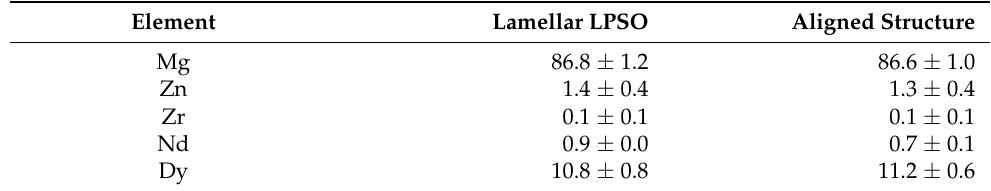
Table 5. Comparison between the chemical compositions of the lamellar LPSO structures found in the air-cooled platelets and the aligned structures after potentiodynamic polarisation in wt.% with indication of the standard deviation